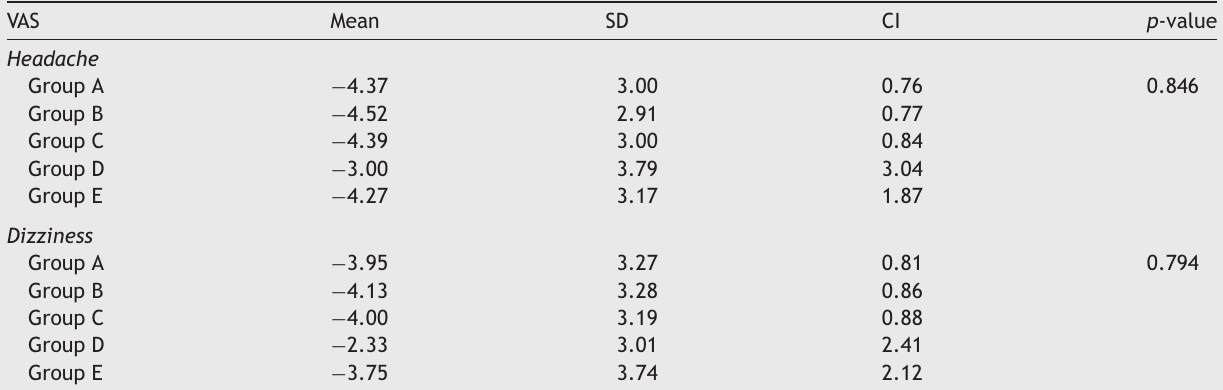
Table 7 Mean of gain for visual analogue scale scores for headache and dizziness by subgroups of patients.